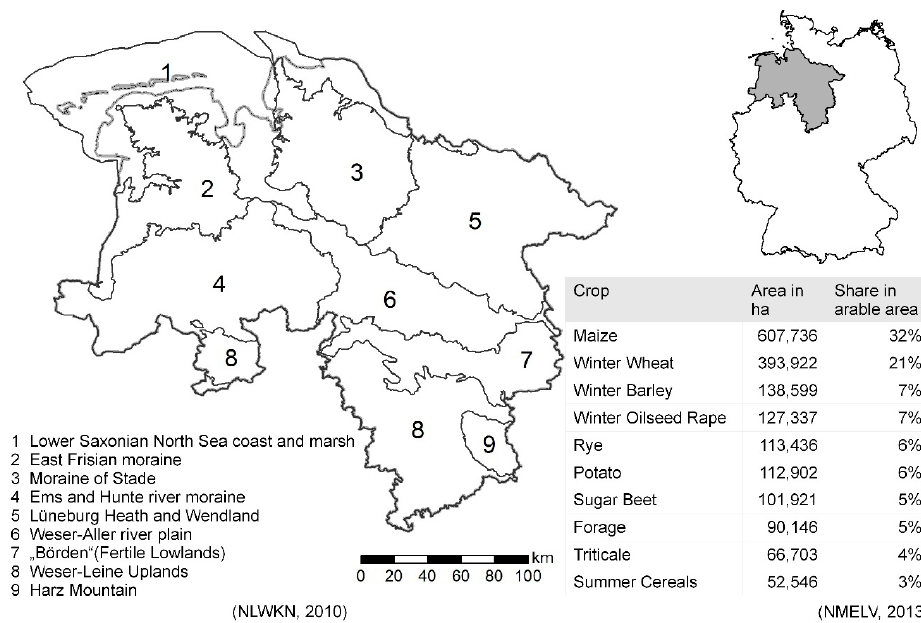
Figure 1. Natural area classification of the German federal state of Niedersachsen (Lower Saxony NUTS 1 region DE9 (European Nomenclature of Territorial Units for Statistics)) and the acreage of the ten main crops or crop groups in 2011, forage includes arable and temporary grassland and fodder legumes